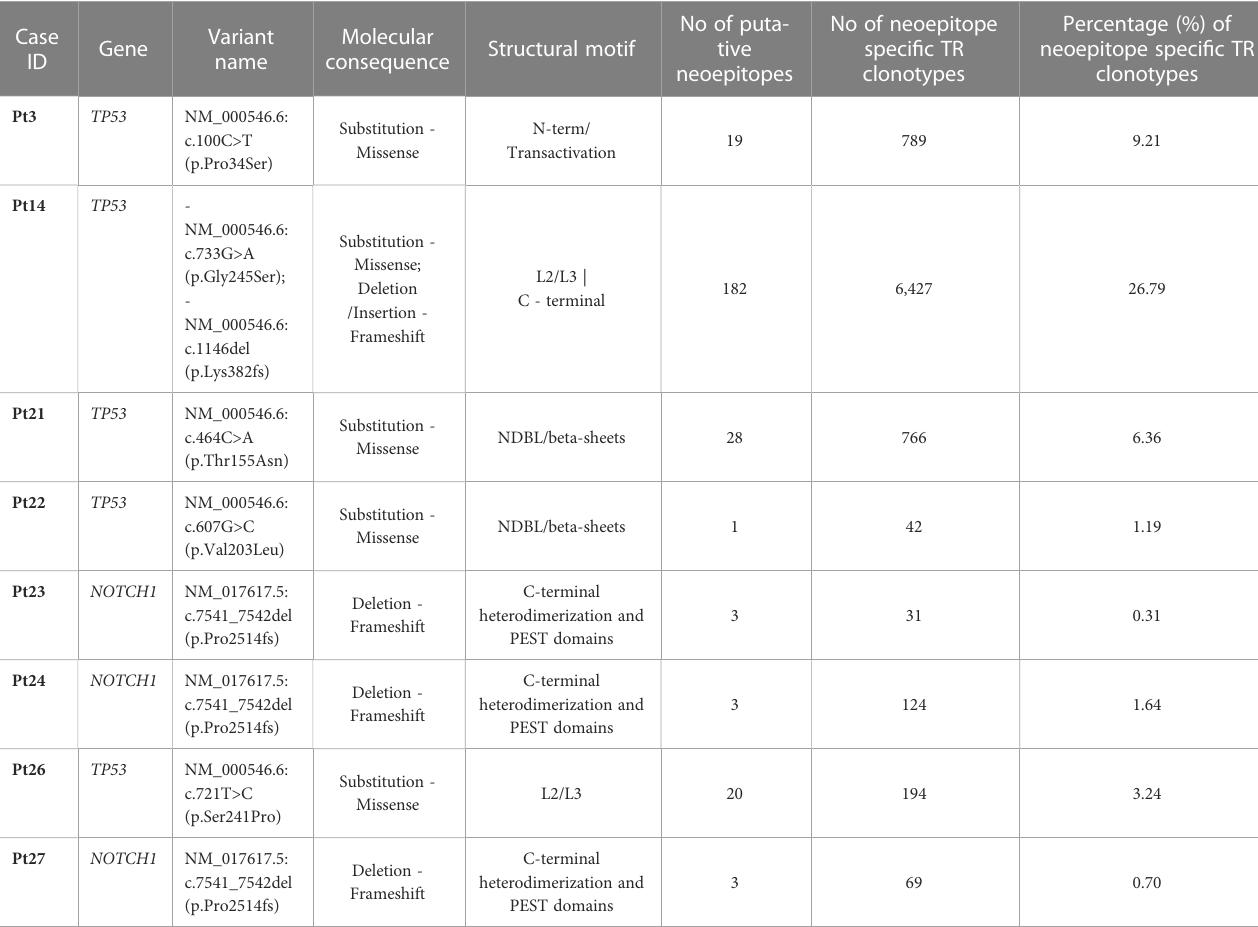
TABLE 1 Putative neoepitopes and predicted neoepitope-speci fi c TR clonotypes in cases with TP53 or NOTCH1